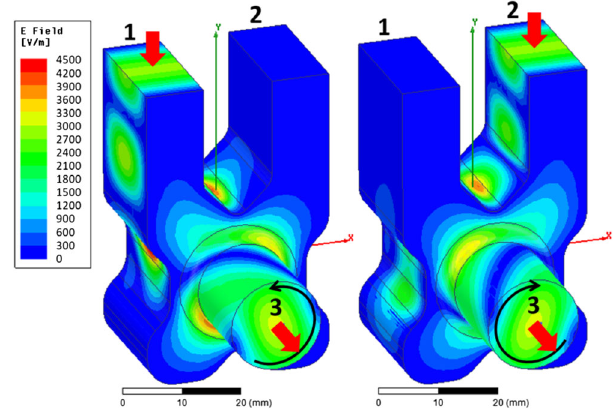
FIG. 5. E-rotator geometry and electric field distribution for 1 W of input power into port 1 (left) and port 2 (right). The polarization of the circular TE 11 mode in the output port is indicated using black